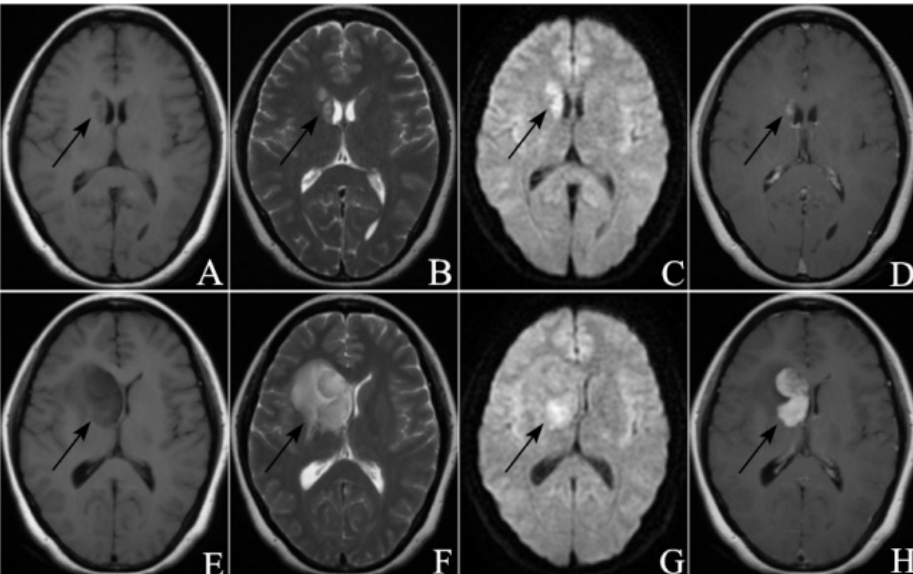
Figure 3. A sixty-seven-year-old male PCNSL patient didn’t receive consolidation WBRT after initial MTX chemotherapy, and the PFS1 was 11.2 months. KPS of this patient was 70 at first relapse. ( A – D ) were MRI images before HD-MTX rechallenge, and ( E – H ) were MRI images 60 days after treatment (( A , E ) from T1WI, ( B , F ) from T2WI, ( C , G ) from DWI, ( D , H ) from CE-T1WI). The tumor was located in the right basal ganglia and showed homogeneous enhancement. After treatment, the tumor obviously enlarged and the edema aggravated, and this patient was judged as PD.